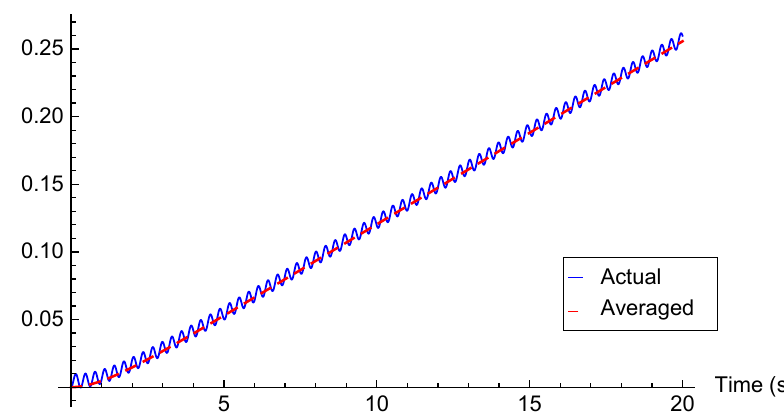
Figure 2. Time histories of the original and averaged systems’